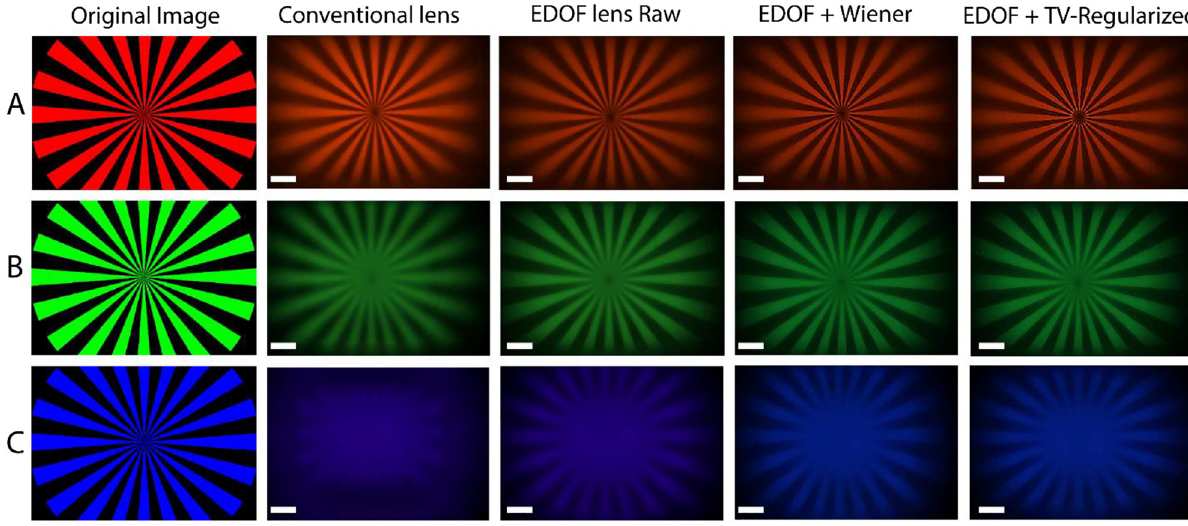
Figure 3: Imaging at discrete wavelengths. The appropriately croppedoriginalobject patternsusedforimagingare showninleftsideof the figure.Imageswerecapturedwith thesinglet traditional metalens, the EDOF lens without, and with deconvolution (EDOF + Wiener), and with the total variation (TV) regularization. Images were captured using narrowband (bandwidth of 20 nm) LEDs with center wavelengths at (A) 625 nm, (B) 530 nm, and (C) 455 nm wavelength. The scale bars correspond to 100 μ